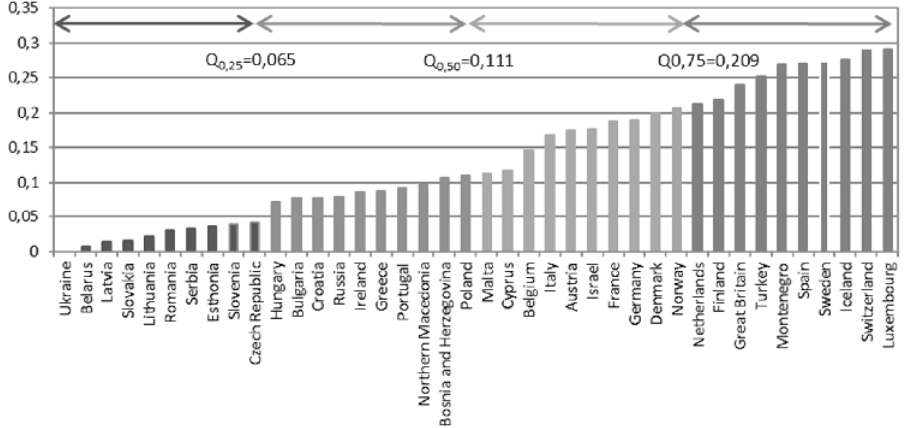
Figure 1. Ranking of exchanges according to the level of development measured by the value of SDI